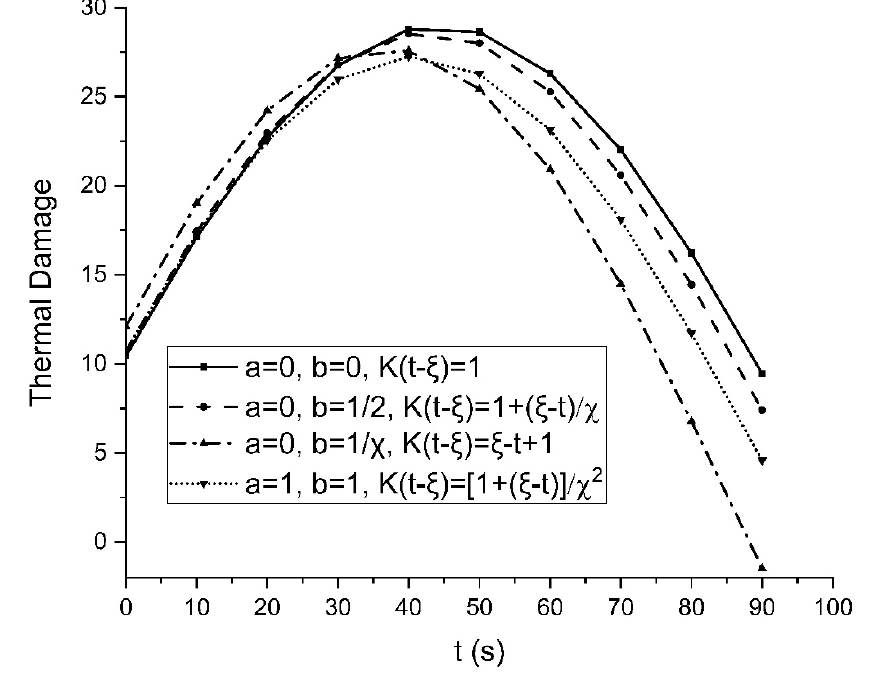
𝐾𝐾 ( 𝑡𝑡 − 𝜉𝜉 ). and a=1, b=1. 2 [1 + ( 𝜉𝜉 − 𝑡𝑡 ) 𝜒𝜒⁄ ]